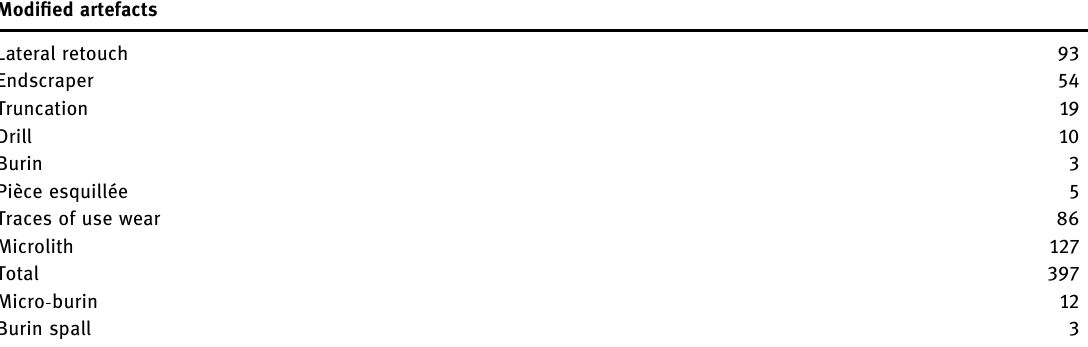
Table 6: Tool classes